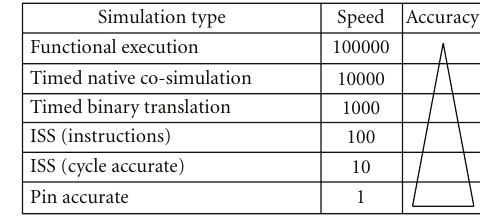
Figure 7: Trade-o ff between speed and accuracy